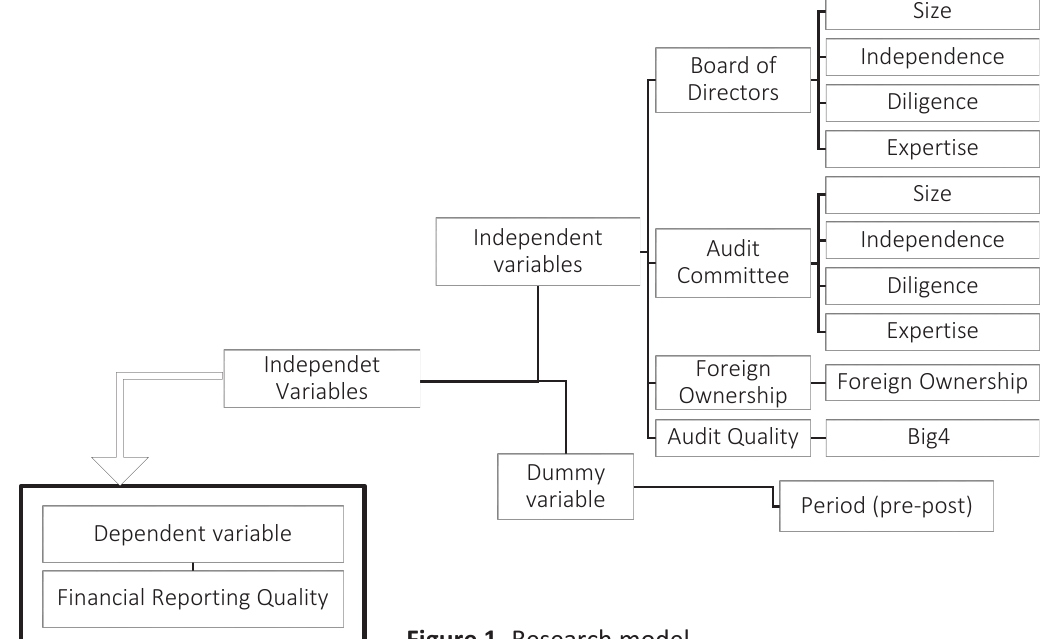
Figure 1. Research